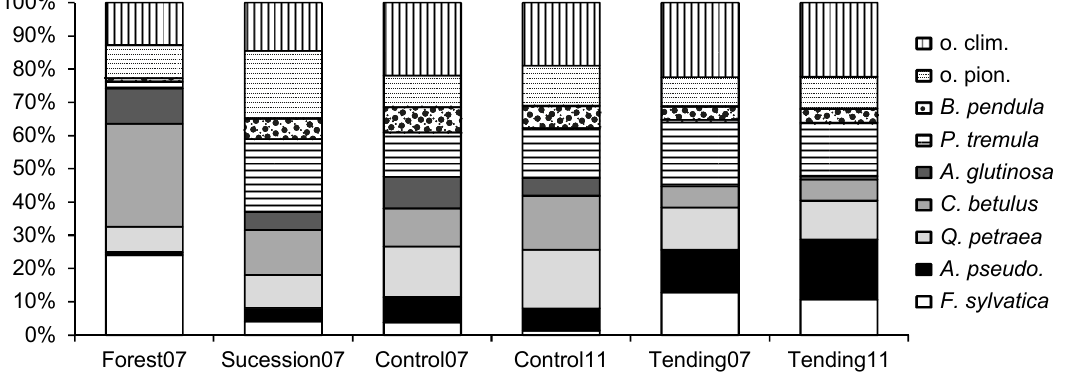
Figure 4. Comparison of tree species composition according to density by treatment for all trees with d.b.h. >2 cm; bars from the left to the right represent the following: Forest in 2007, Succession in 2007, crop trees in Control in 2007 and 2011, and crop trees in Tending in 2007 and 2011; legend: o. clim.—other climax species, o. pion.—other pioneer